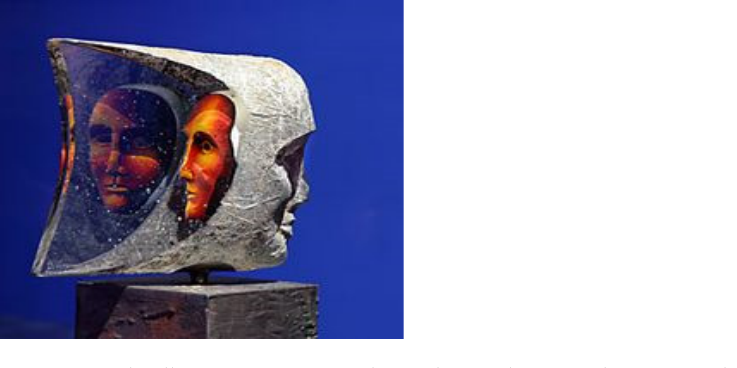
Figure 9. Bertil Vallien; Janus , 2011; sand cast glass sculpture with copper and colour oxides inclusions; courtesy of the artist, used with permission.